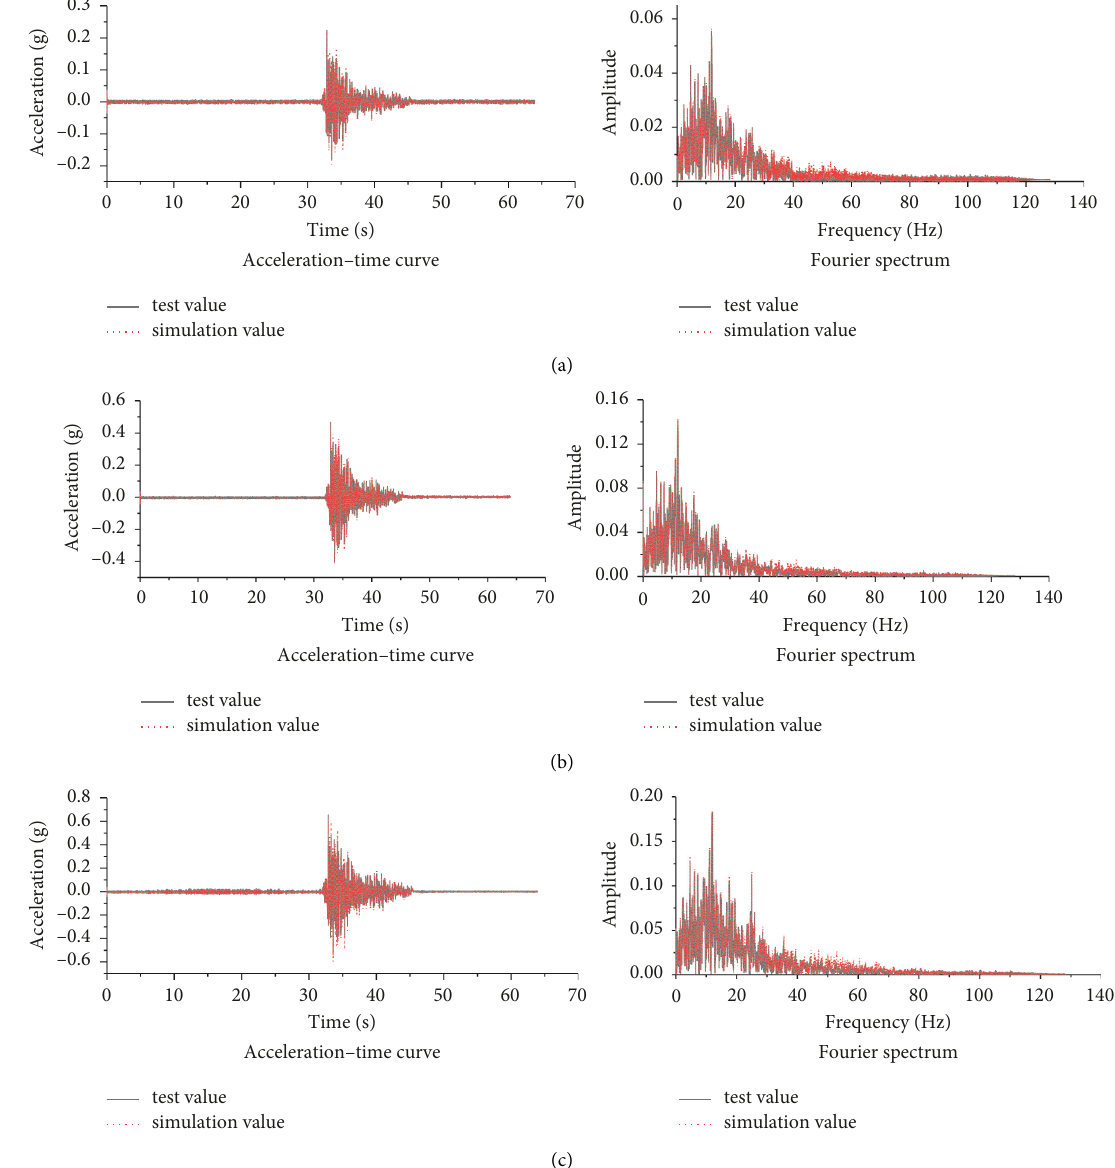
Figure 5: Comparison of acceleration-time curve and Fourier spectrum test value and simulation value at the bottom of 2 # pile: (a) under the action of seismic wave of 0.2g Taft, (b) under the action of seismic wave of 0.4 g Taft, and (c) under the action of seismic wave of 0.6g